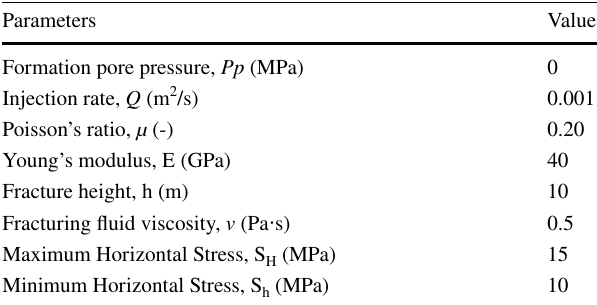
Table 3 Input parameters for the model